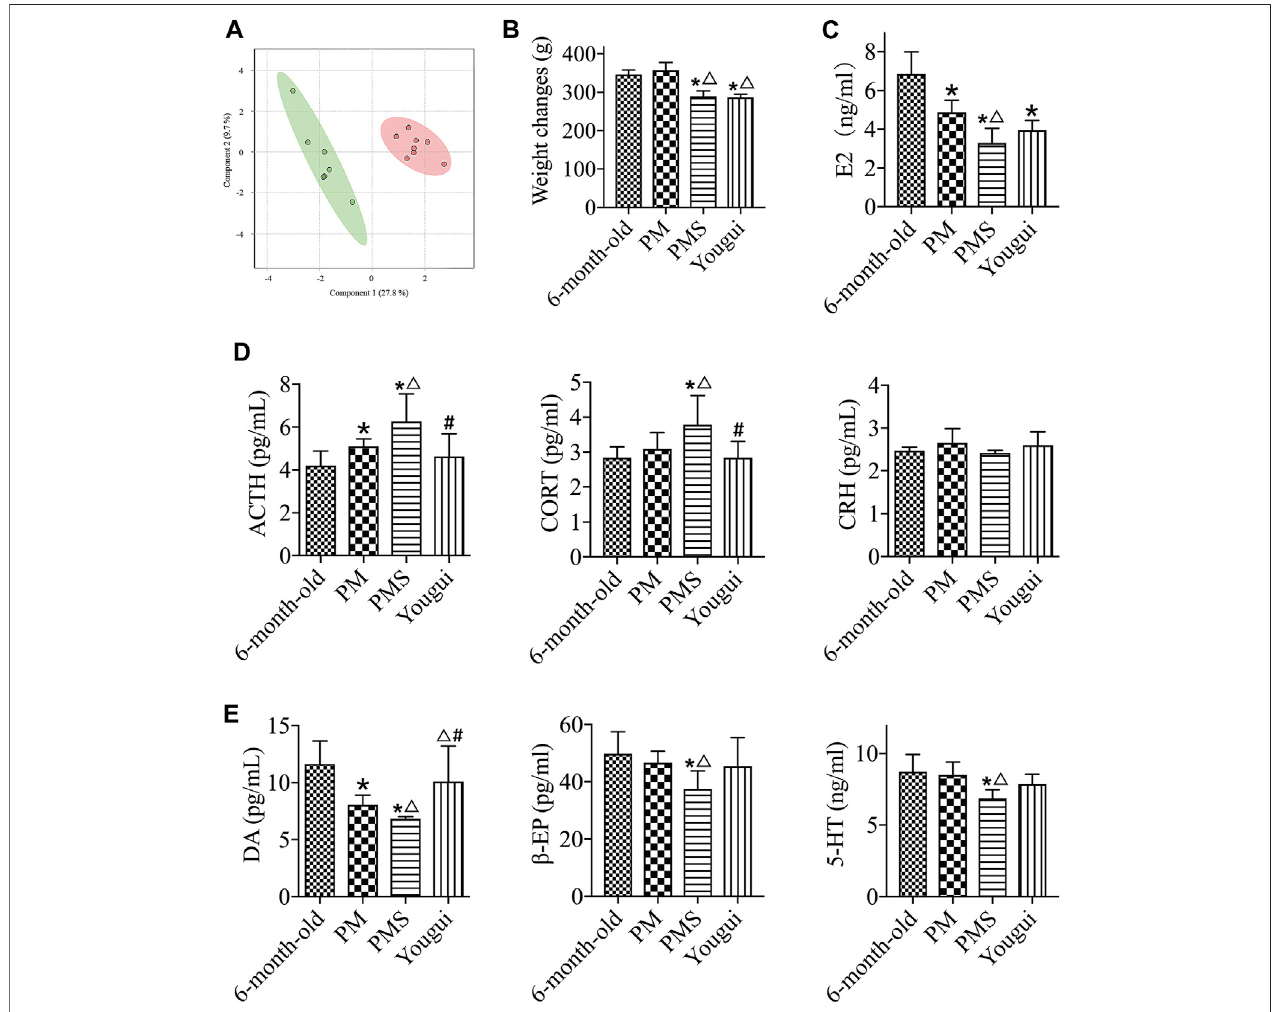
FIGURE 3 | Treatment with Yougui. (A) The metabolomics state of PMS (red) further progressed away from the original state after 4 weeks of gavage with a saline solution(green).Themetabolicstatechangedrapidly. (B) WeightchangesofPMSratstreatedwithYougui.Therewasnostatisticallysigni fi cantdifferenceintheweightof PMS rats before and after treatment with Yougui. (C) Treatment ofYougui did not result in astatistically different E2 level in PMS rats. (D) ELISA results ofACTH, CORT, andCRH.ComparedwithPMSrats,thelevelsofACTHandCORTwerereducedaftertreatmentwithYougui. (E) ThelevelsofDA, β -EP,and5-HT.Comparedwith PMS rats, the levels of DA were enhanced after treatment with Yougui. “ * ” indicates the comparison with 6-month-old rats [ p < 0.05 (*)]; “ △ ” indicates the comparison with the perimenopausal rats [ p < 0.05 ( △ )]; “ # ” indicates the comparison with the PMS rats [ p < 0.05 (#)].